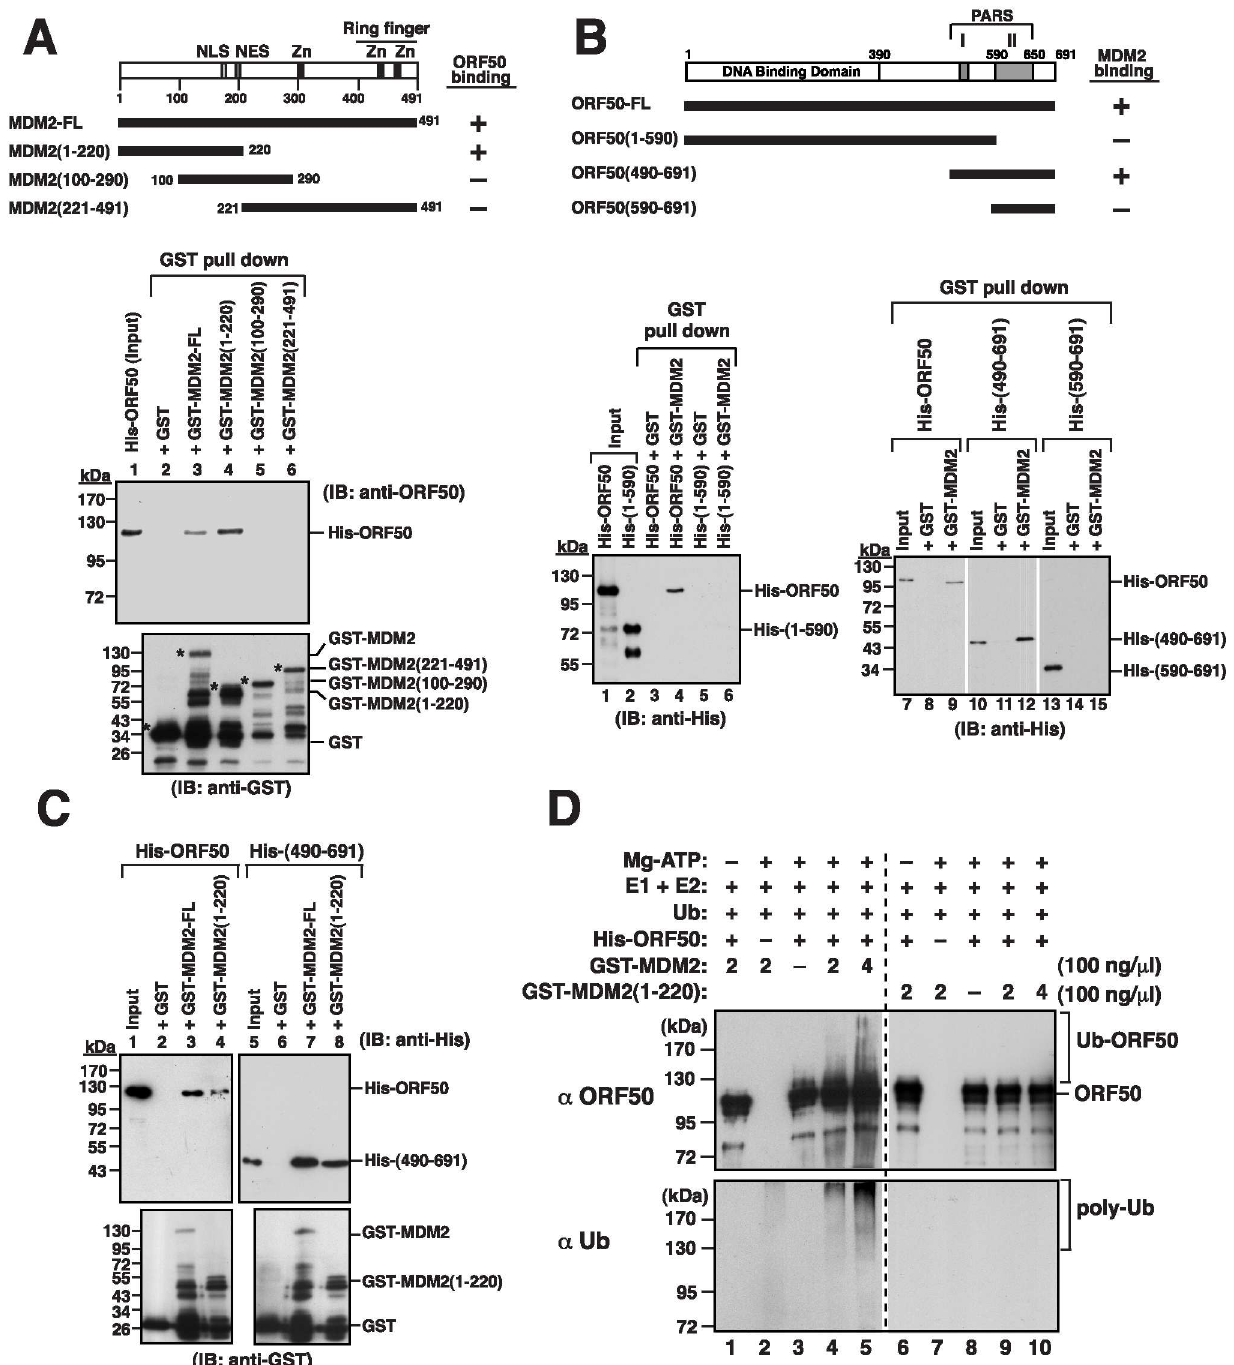
Fig 10. Mapping of the interaction domains between MDM2 and ORF50, and ubiquitination of ORF50 by MDM2 in vitro . (A) Defining the ORF50-interacting domain of MDM2. The purified His-tagged ORF50 (His-ORF50) was incubatedwith GST, GST-MDM2 or GST-MDM2 deletion mutants (1–220, 100–290and 221–491)expressed in E . coli . Followingpull-downwith glutathione beads, the pull-downlysates were immunoblotted with anti-ORF50 or anti-GST antibody. (B) Definingthe MDM2-interacting domain of ORF50. Glutathione beads conjugatedto GST-MDM2 were incubatedwith His-ORF50 or His-ORF50 deletions as shown in the diagram. The GST pull-downprecipitates were immunoblotted using anti-His antibody. (C) Detection of the interactionbetween GST-MDM2(1–220) and His-ORF50(490–691) in pull-down assay. (D) Effect of MDM2 on ORF50 ubiquitination in vitro . The in vitro ubiquitantion assay was performed using purified components as indicated. In the reactions, purified His-ORF50 protein was used at a final concentration of 120 nM and GST-MDM2 (or